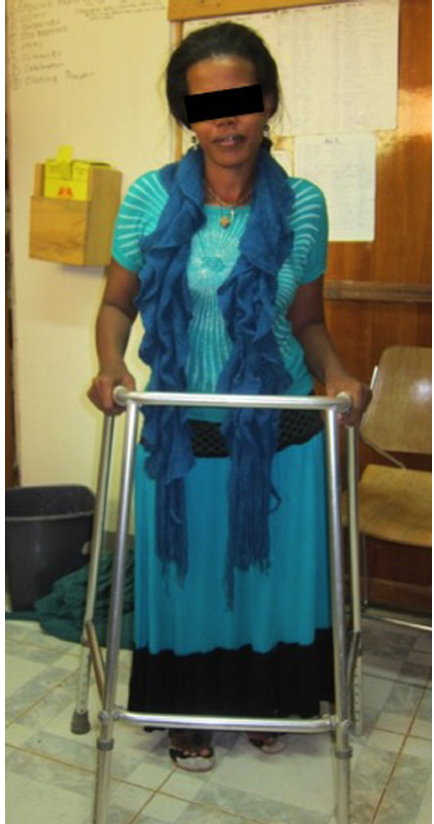
Figure 5. Postoperative photograph of patient with knee fusion for congenital knee dislocations walking with